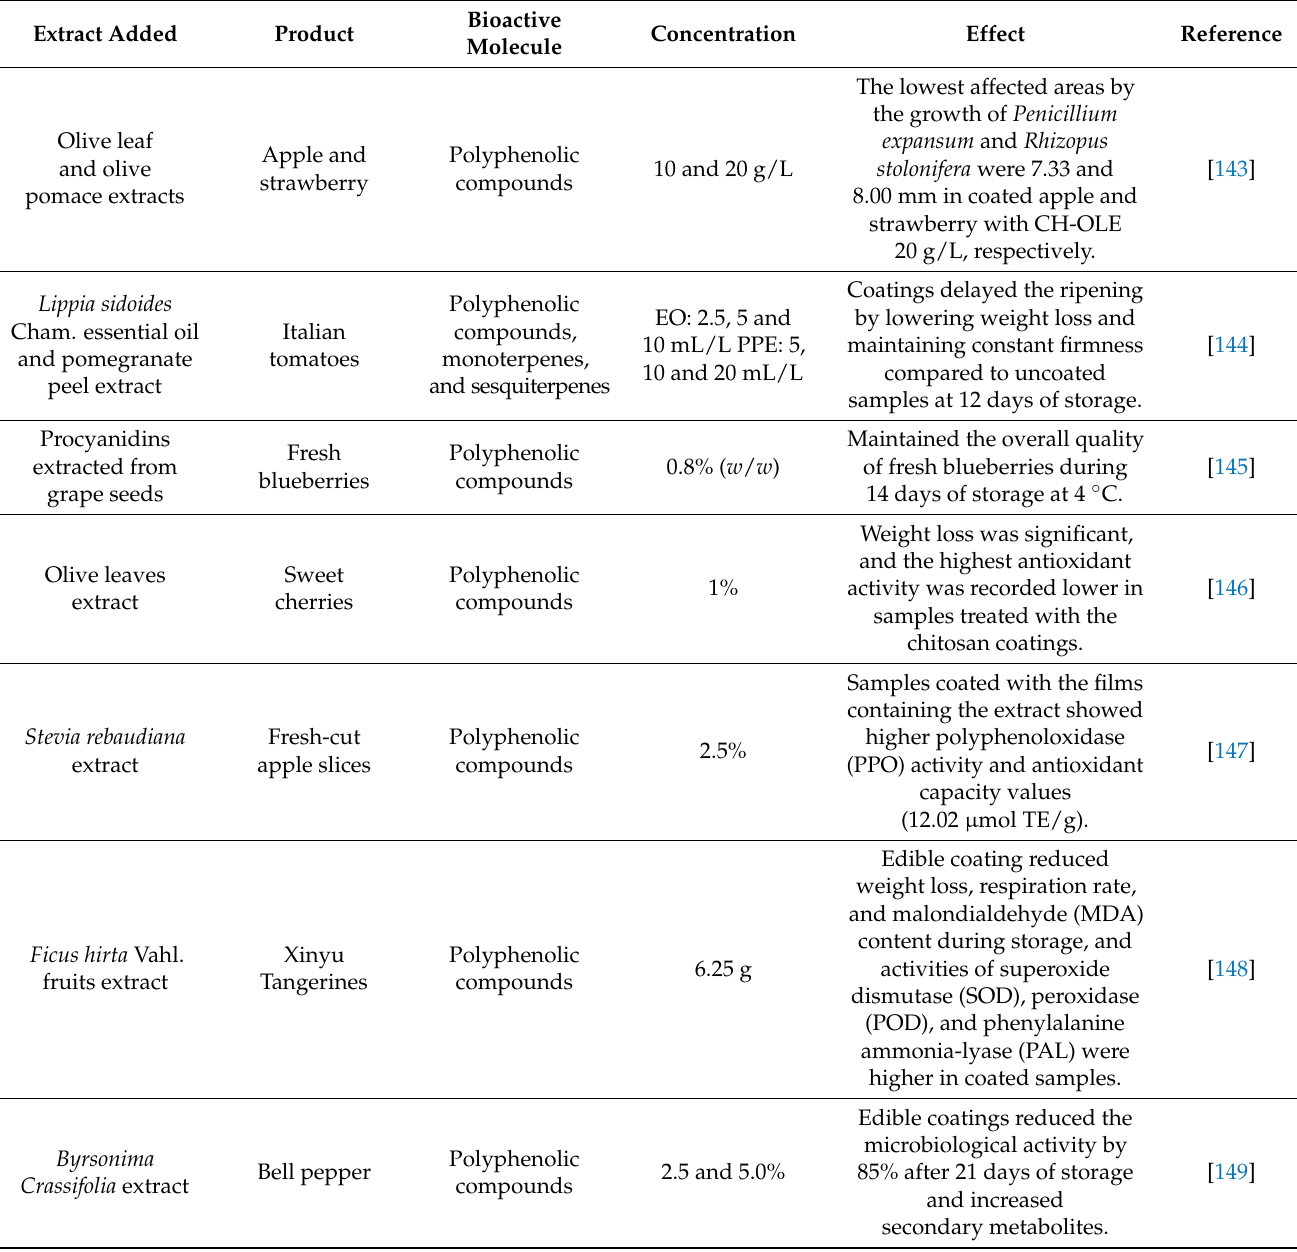
Table 6. Natural extracts added to chitosan-based films and coatings for fruits and